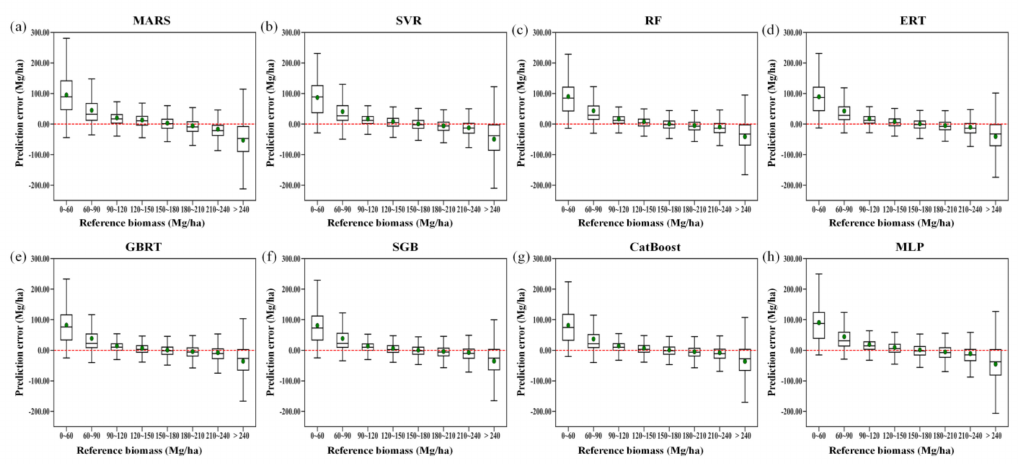
Figure 9. Residual analysis of di ff erent modeling results obtained by the MARS, SVR, RF, ERT, GBRT, SGB, CatBoost, and MLP algorithms ( a – h ), along with the reference AGB ranges, under the random sampling